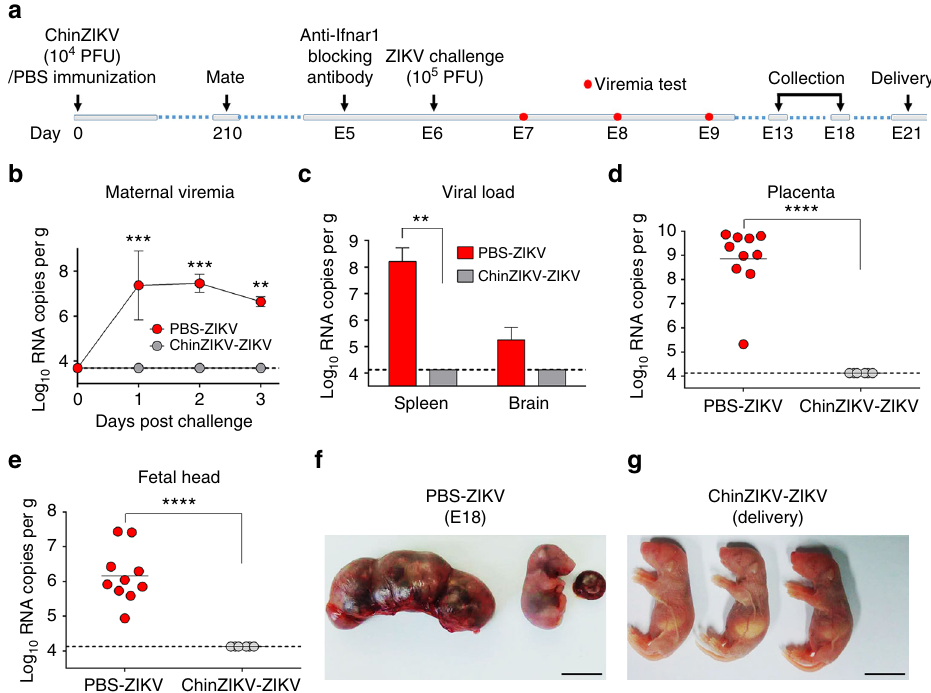
Fig. 5 ChinZIKV immunization prevents vertical ZIKV transmission and fetus injury during pregnancy. a Scheme of immunization of BALB/c female mice with 10 4 PFU of ChinZIKV or PBS. b – e At day 210 post immunization, vaccinated female mice were mated with BALB/c males. Pregnant mice ( n = 3) were administered 2.0 mg of anti-Ifnar1-blocking antibody on E5 and 1 day later (E6) challenged with 10 5 PFU of ZIKV. Viral RNA loads in serum at days 1 – 3 post challenge were determined by RT-qPCR b . On E13, animals were killed; maternal spleens and brains c , placenta d , and fetal heads e were collected and viral RNA levels were quanti fi ed by RT-qPCR. The data are representative of at least three independent experiments and error bars indicate the SD. f , g Outcome of fetuses from PBS or ChinZIKV vaccinated dams. Scale bar: 1 cm. f Representative images of hemorrhagic uterus (left) and moribund fetus (right) recovered from PBS-immunized moribund dams at E18. g Representative images of pups delivered at term to ChinZIKV vaccinated dams. Dotted lines indicate the detection limit. Signi fi cance was calculated using a two-way ANOVA with multiple comparison tests b (** P -value < 0.01; *** P -value < 0.001) or a Student ’ s t -test c – e (** P -value < 0.01; **** P -value <